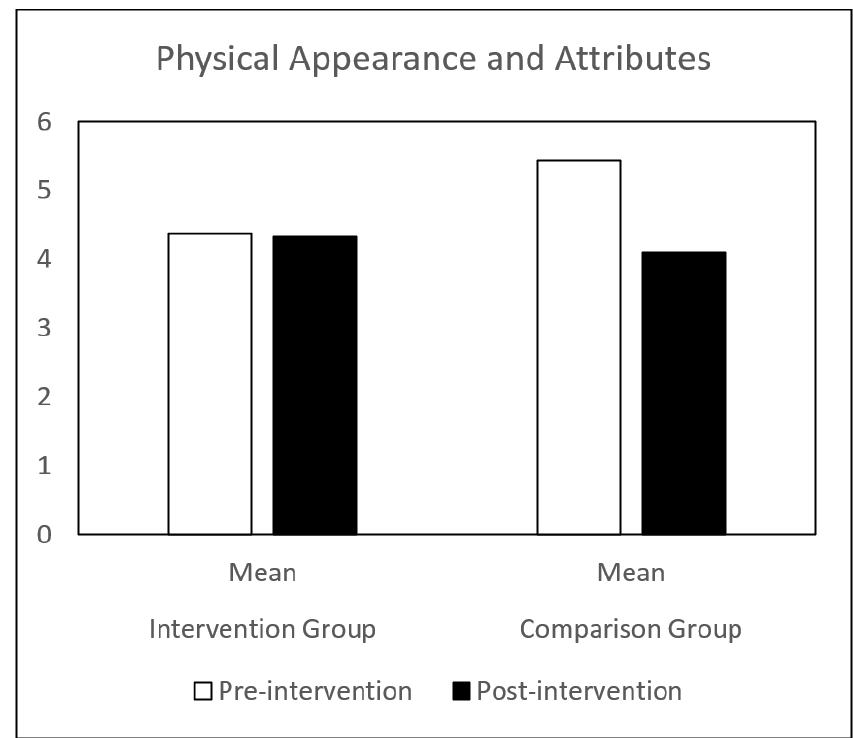
Figure 2. Intellectual and School Status mean in IG and CG at pre- and post-intervention.